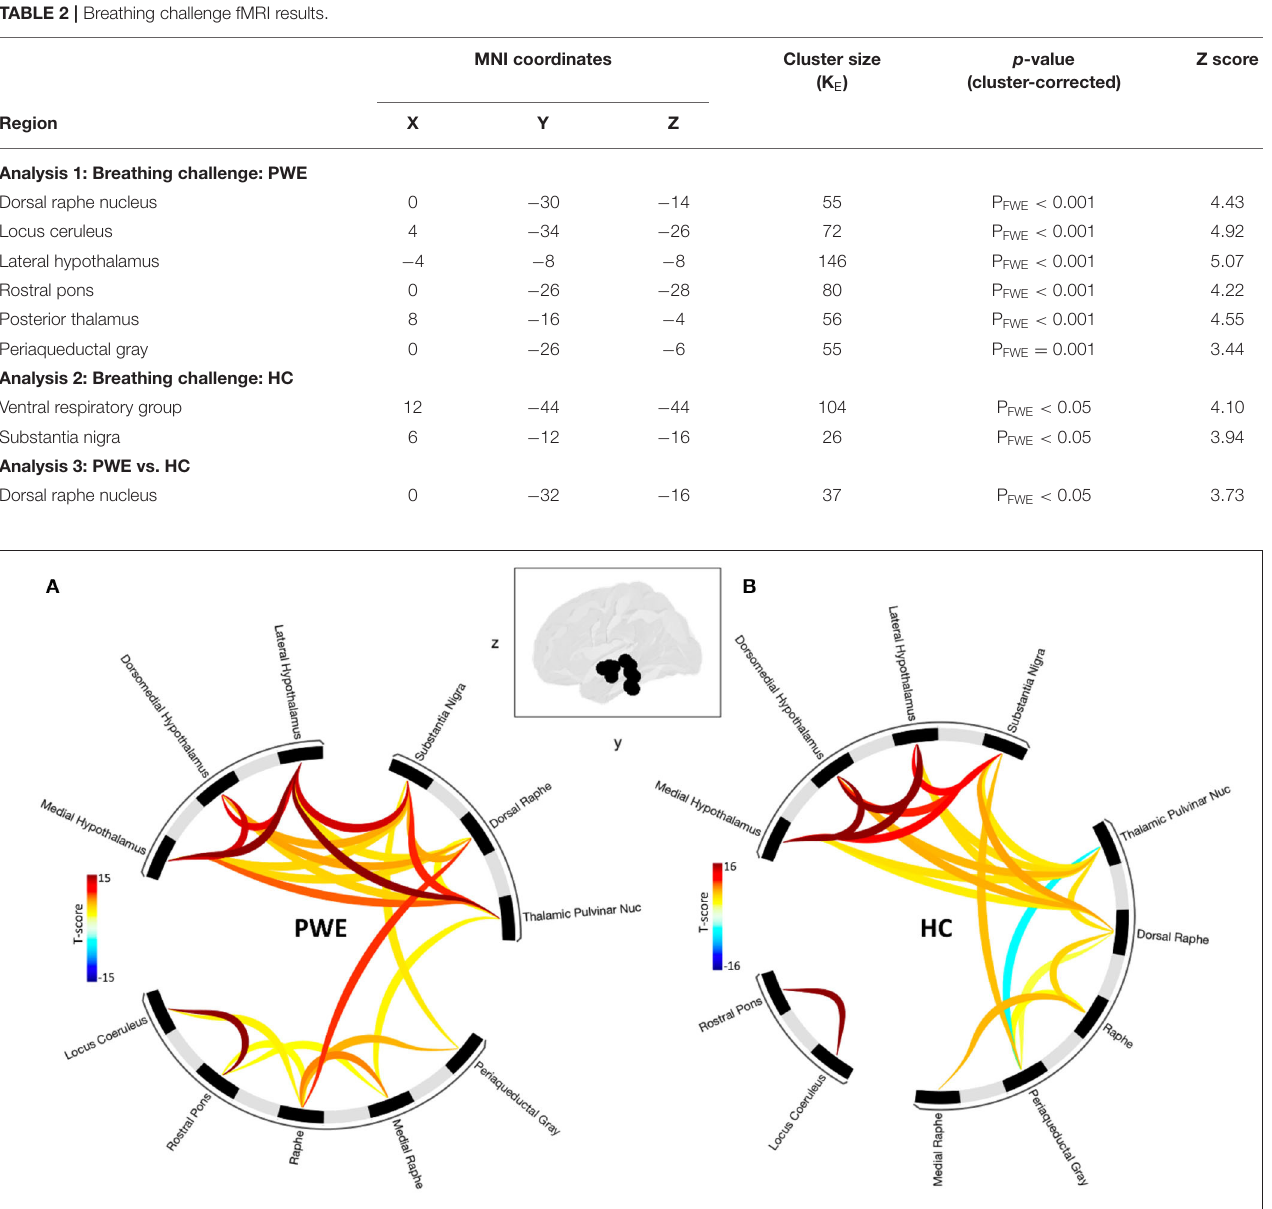
TABLE 2 | Breathing challenge fMRI results.